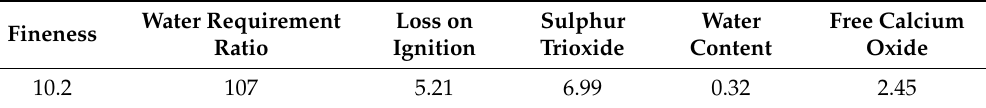
Table 2. Properties of high-sulphur fly ash.